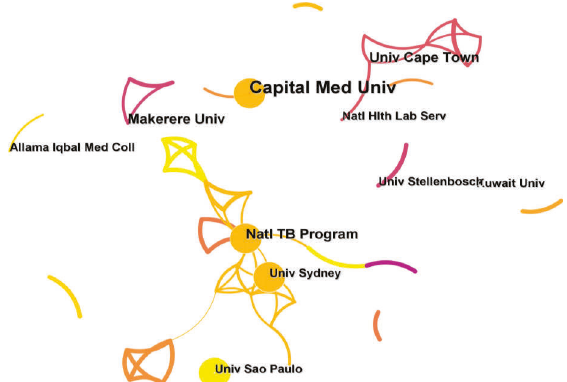
Figure 7: Affiliation cooperation network of published papers for GeneXpert in